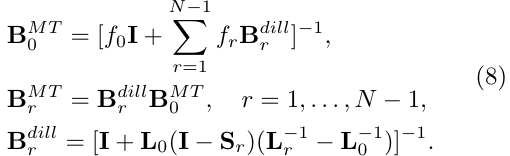
Figure 5. Geometry and plane view of discretized PUCs: a) earlywood, b)